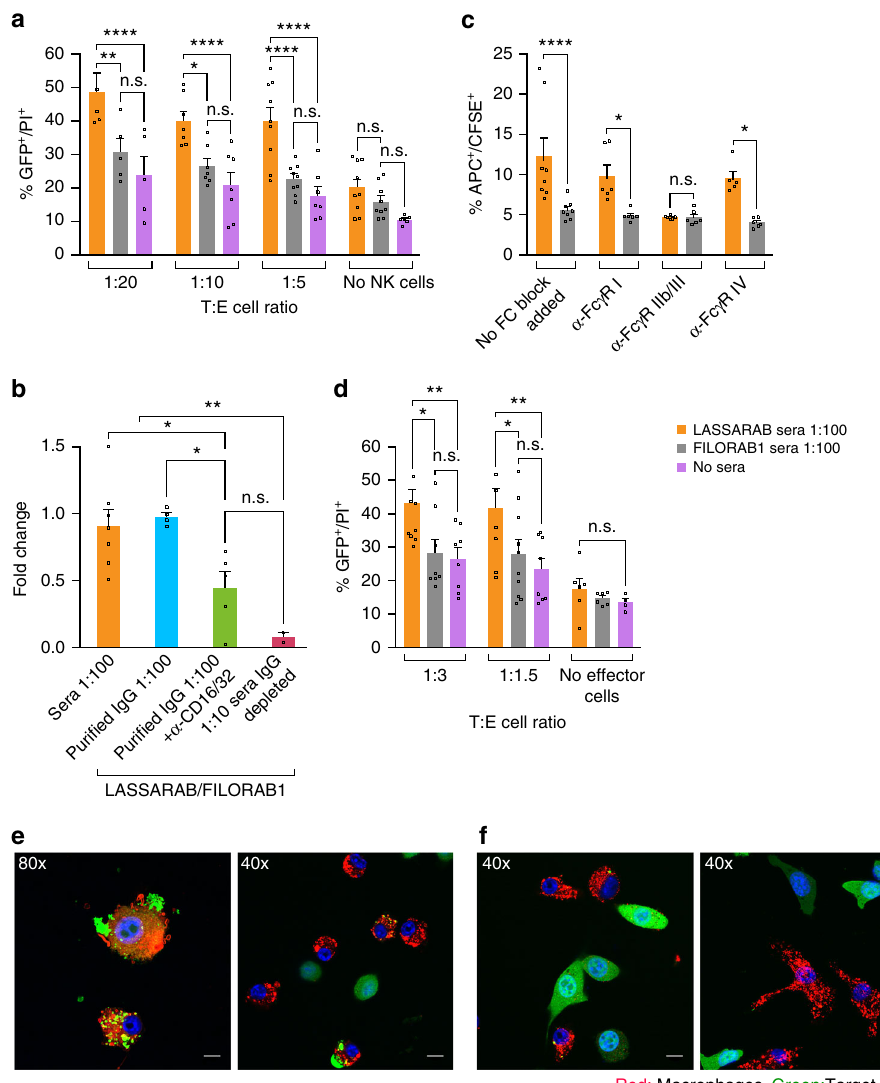
Fig. 7 Evaluation of antibody effector cell functions mediated by murine NK and macrophage cells against 3T3 expressing LASV GPC. Day 42 sera from immunized mice was incubated with 3T3-LASV cells and 30 min either murine NK or macrophage cells were added and results were analyzed 4 h later by either fl ow cytometry (Supplementary Fig. 3 and a – d ) or confocal microscopy ( e ). Puri fi ed murine C57BL/6 NK cells ( a ) or IC-21 macrophages ( d ) were added at different Target:Effector cell ratios (T:E) with target cells incubated with either LASSARAB sera (yellow), FILORAB1 sera (gray) or no sera (pink). The Y -axis represents the percentage of cellular cytotoxicity based on GFP + /PI + cells (gating strategy and fl ow plots in Supplementary Fig. 3). b